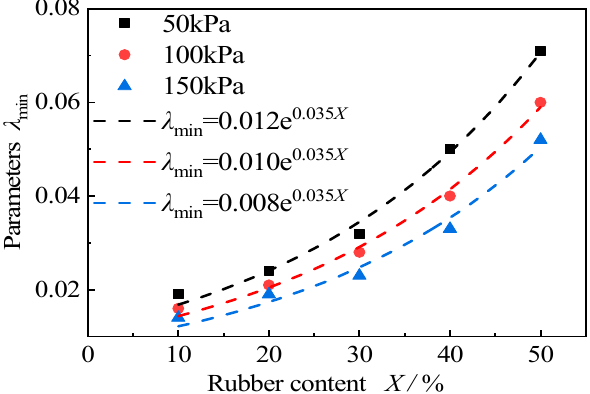
Figure 29. The fitting curve of the initial damping ratio. Table 5. The fitting parameters, K and n.